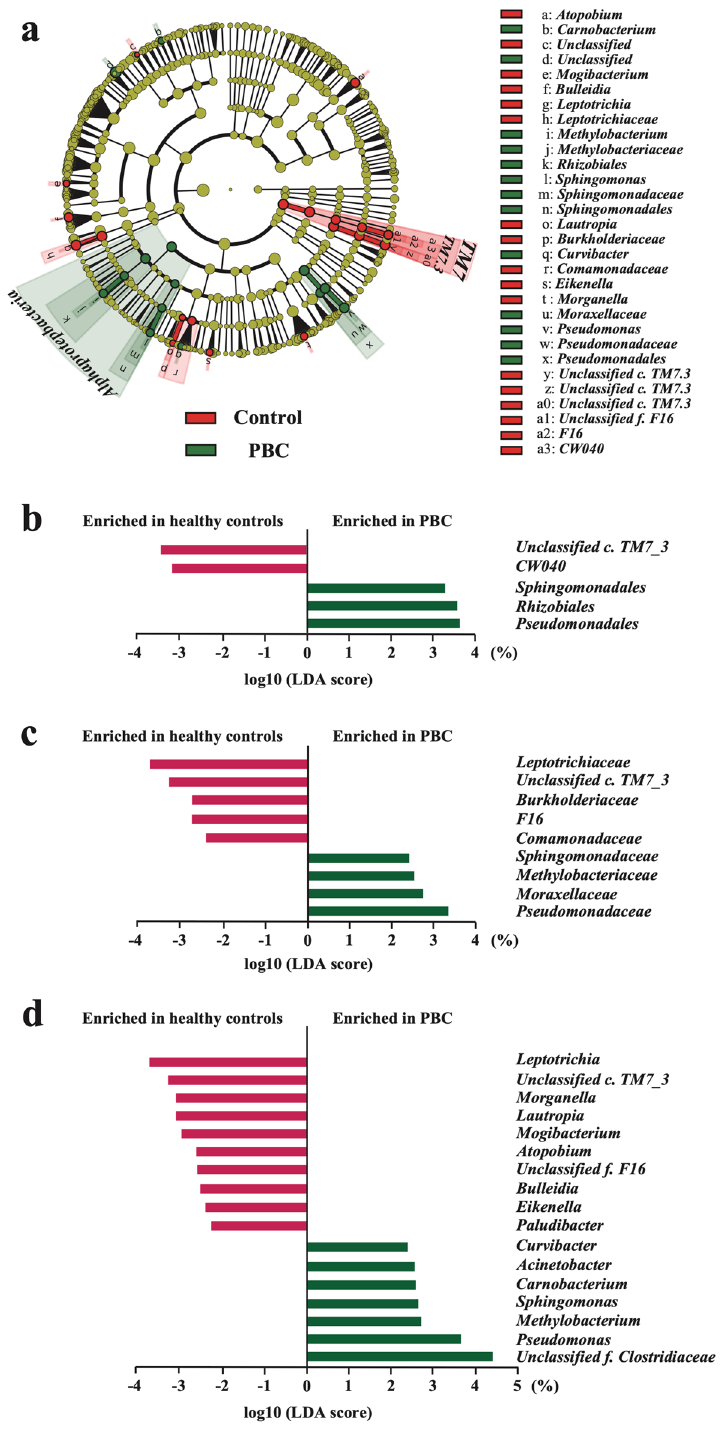
Figure 3. Changes in gut bacterial taxonomic abundance in patients with PBC ( n = 34) compared with HCs ( n = 21). ( a ) Bacterial taxa identified to be rich based on the differences between the groups analyzed by LEfSe (LEfSe v1.0, https// huttenhower.sph.harvard.edu/lefse/) (Logarithmic LDA score > 2.0). Bacterial taxa of the patients with PBC were compared with those of HCs at various levels. Bacterial taxa with high numbers of bacteria in the PBC group are shown in green, and bacterial taxa with high numbers of bacteria in the HC group are shown in red. In addition, the bacterial taxa showing insignificant differences in their abundance between the two groups are shown in yellow. LEfSe identified Alphaproteobacteria as a differentially abundant taxon in the PBC group versus the HC group. ( b ) Order-level relative abundance of bacteria in the PBC group compared with that in the HC group. ( c ) Family-level relative abundance of bacteria in the PBC group compared with that in the HC group. ( d ) Genus-level relative abundance of bacteria in the PBC group compared with that in the HC group. Values are expressed as the median of the interquartile range. PBC, primary biliary cholangitis; HC, healthy control; LEfSe, linear discriminant analysis effect size; LDA, linear discriminant